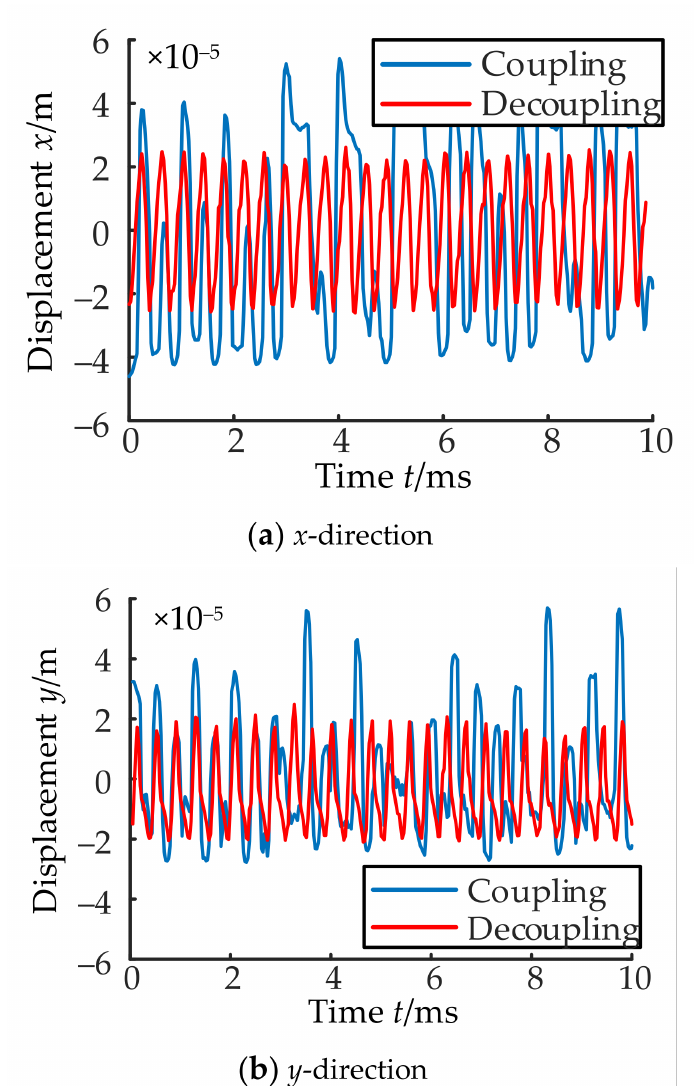
Figure 20. Displacement of the rotor with